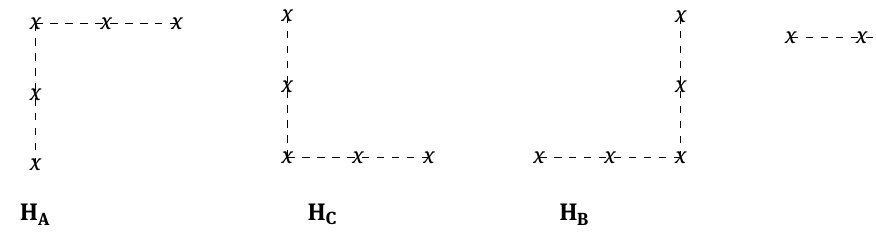
Figure 1: H A , H C , H B , H D are four different shapes